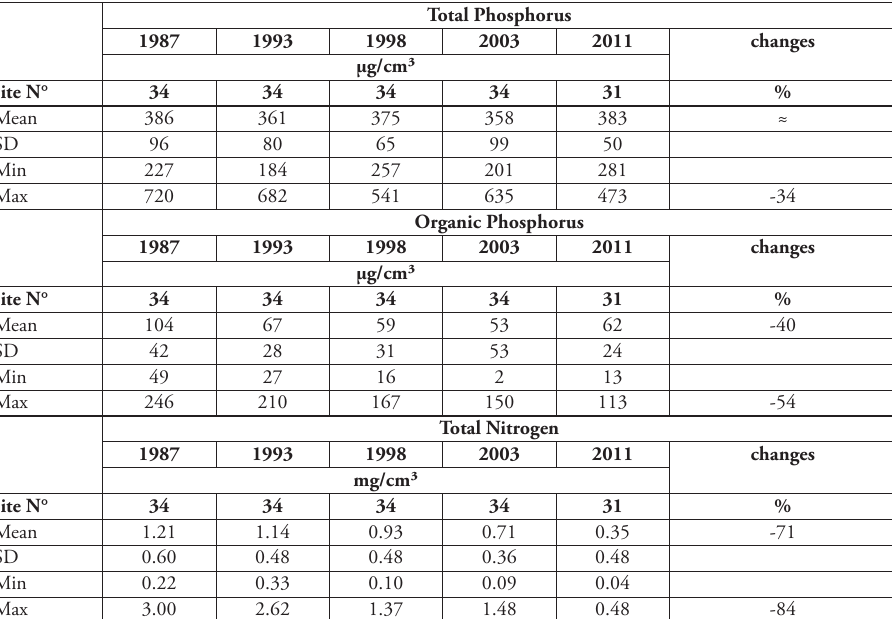
Table 2. Changes of Total Phosphorus, Organic Phosphorus and Total Nitrogen in the central